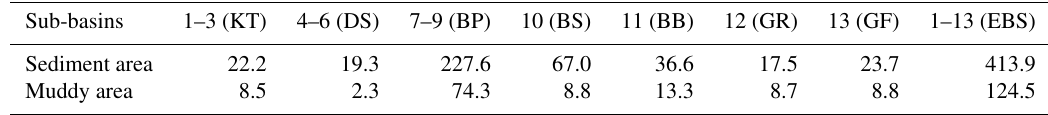
Table 1. Total sediment areas and muddy sediment areas (1000km 2 ). The muddy sediment areas are based on Al-Hamdani and Reker (2007). Sub-basins according to Fig.